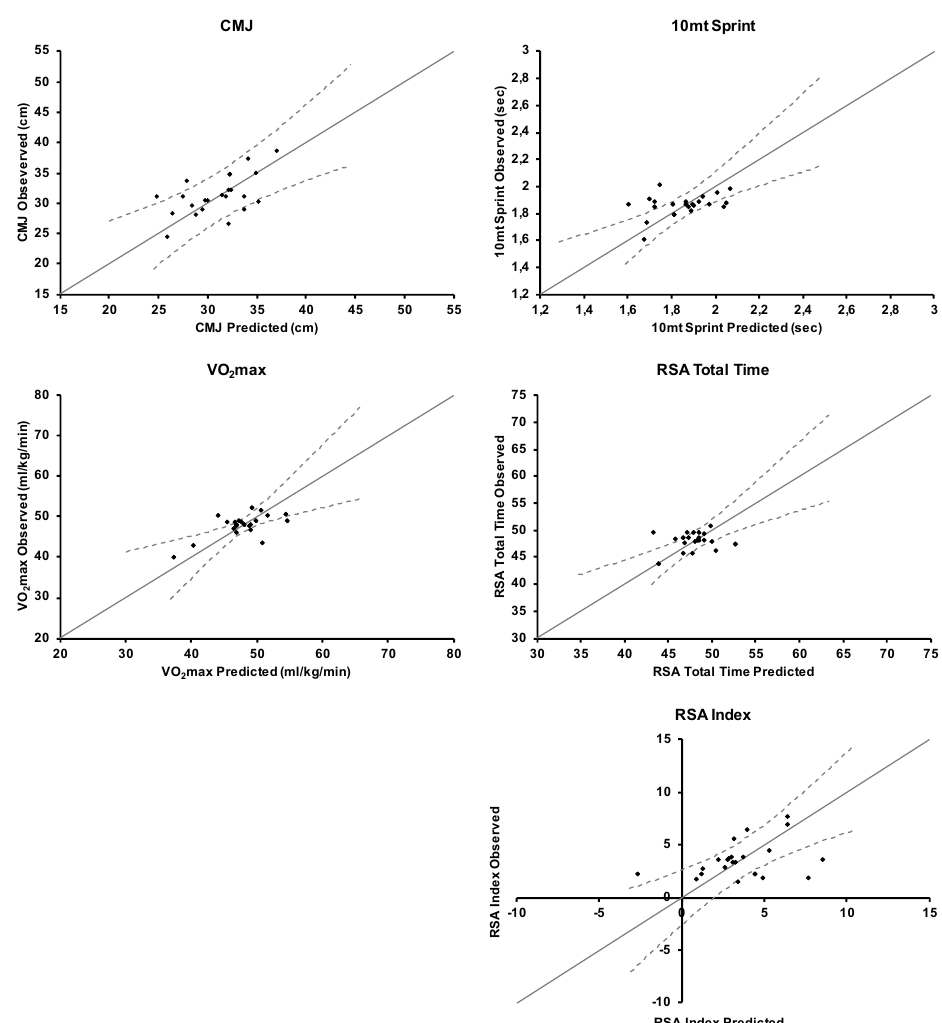
Figure 1. Correlations between predicted ( x -axis) and observed ( y -axis) values of fitness parameters. Dashed lines refer to 95% prediction bands.